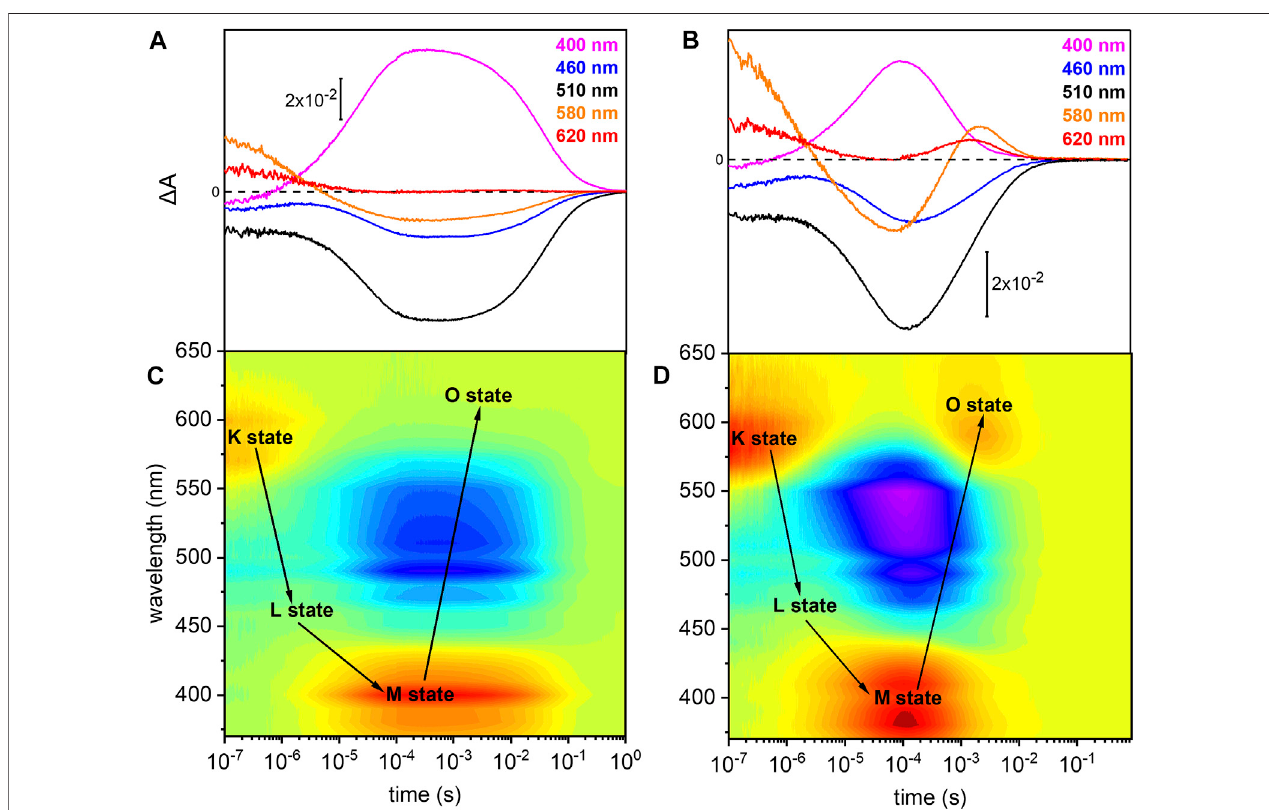
FIGURE3| Photoreactionkineticsof Um Rh1recordedatpH7.4andpH5.Timeevolutionofthe fl ash-inducedabsorptionchangesofDDM-solubilized Um Rh1 (A) inthepresenceof100 mMNaCl,20 mMHEPES,pH7.4,0.03%DDM,and (B) inthepresenceof100 mMNaCl,50 mMbuffermix(10 mMHEPES,MOPS,MES,citrate and glycine), pH 5, 0.03% DDM. The extracted wavelengths at 400, 460, 510, 580, and 620 nm, are characteristic to M state, L state, ground state, K and O states, respectively. Color maps are showing the absorption changes of Um Rh1 at pH 7.4 (C) and pH 5 (D) over the spectral range of 370 – 650 nm and the time range of 10 ns – 1 s.Redcolorindicatespositivebandsfromtheriseofintermediatestatesandbluecorrespondstothenegativeabsorptionchangefromtransientdepopulationof ground-state Um Rh1. The sequential interconversion between the states is shown with solid